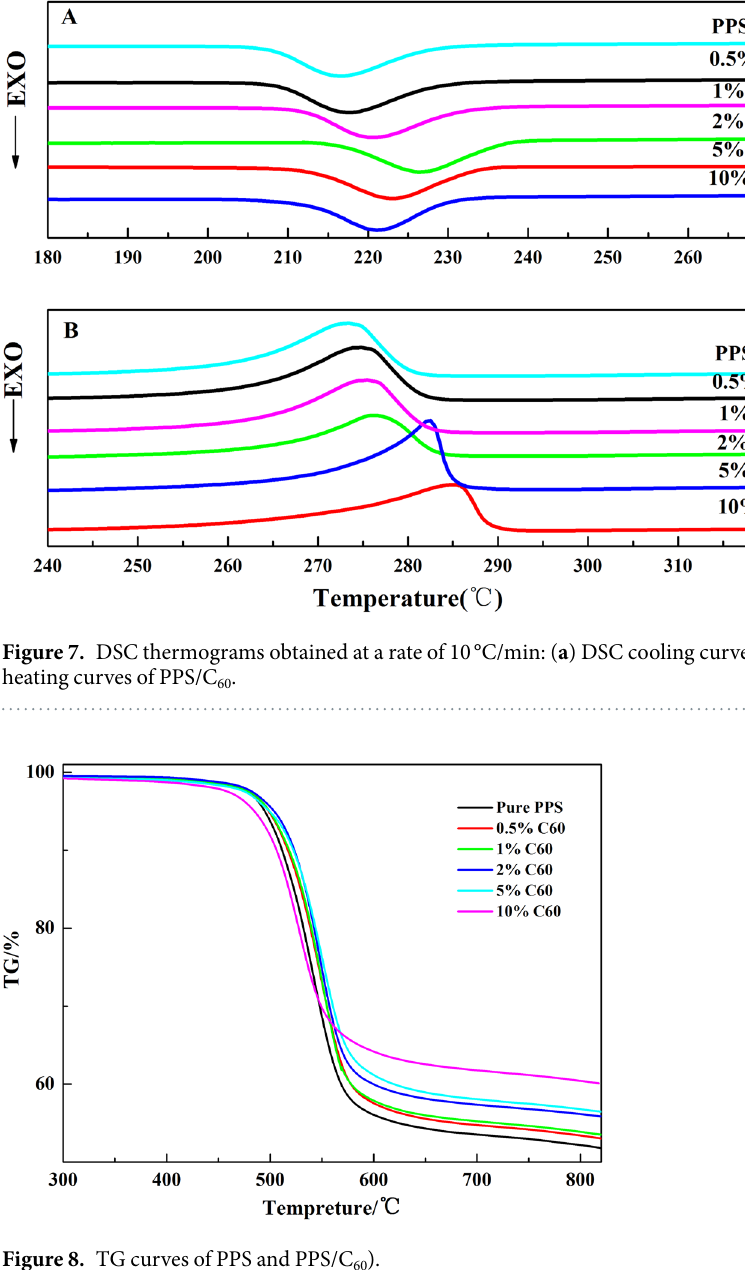
Figure 8. TG curves of PPS and PPS/C 60